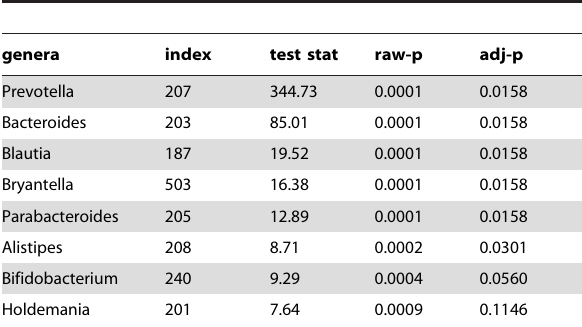
Table 1. Results from the mt function on the ‘‘Enterotypes’’